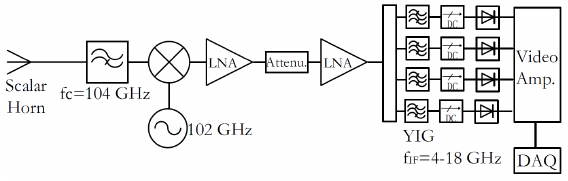
Figure 7. The heterodyne detection part of the CECE diagnostic.